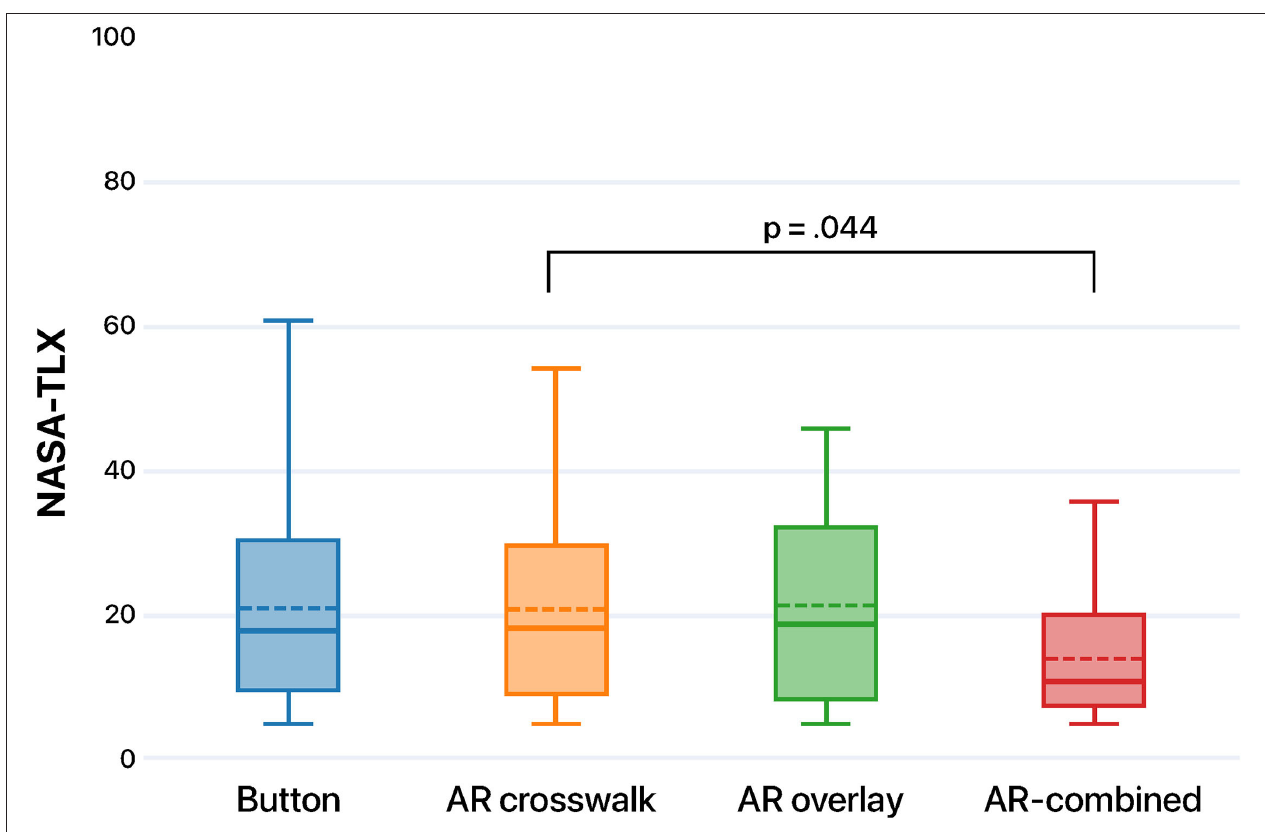
FIGURE 6 | Results of the NASA-TLX questionnaire. Median = solid line; mean = dotted line, p -values reported for significant pairwise comparisons.